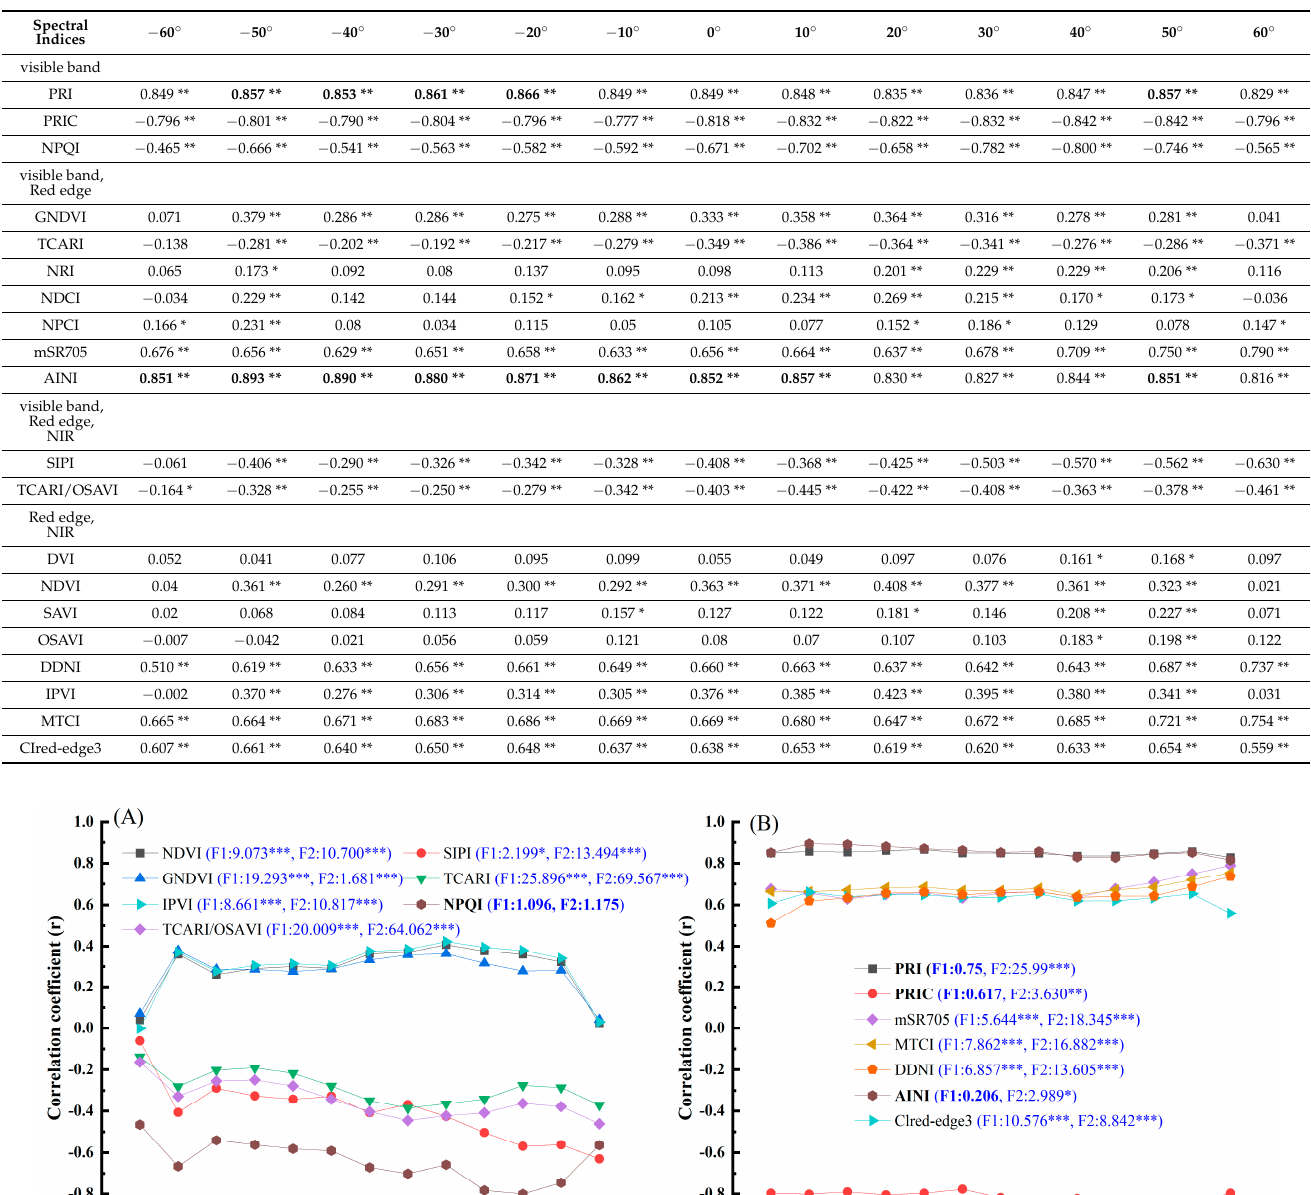
Table 3. Correlation coefficient between ANC and spectral index of cotton with different VZAs.(r) * and ** represent spectral index and ANC correlation. * represents a significant correlation of p < 0.05, ** represents a very significant correlation of p < 0.01. values greater than 0.849 are expressed in bold.